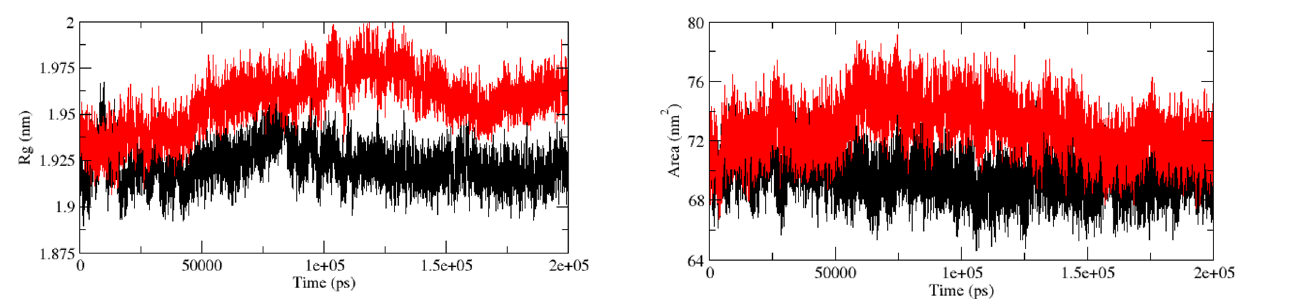
Figure 7. Solvent-accessible surface area (SASA) of native and mutant Aurora-A protein versus time at 300 K. Native is shown in black and mutant in red.